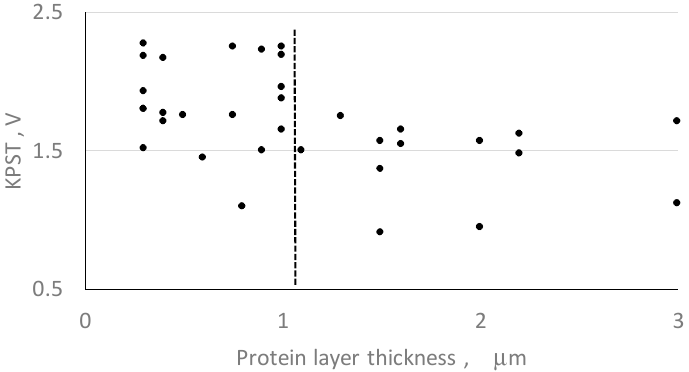
Figure 4. KPST voltage influenced by the thickness of the protein.